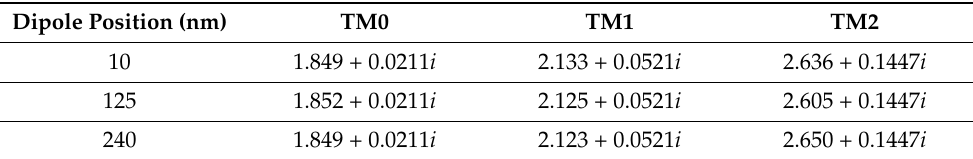
Table 2. Effective mode indices of TM modes obtained by the Lorentzian line shape-based fitting to the total power dissipation